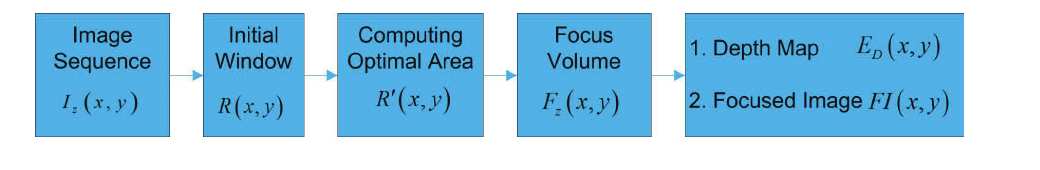
Figure 5. The diagram of the proposed method.